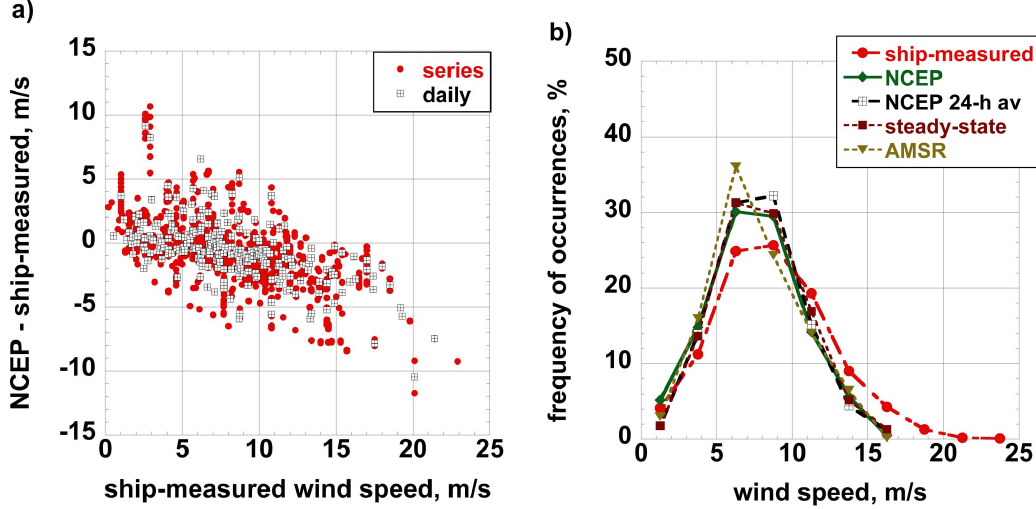
Fig. 3. Differences between NCEP and ship-based wind speed as a function of ship-based wind speed (a) and wind speed frequency of occurrences (%) for each subset (b)